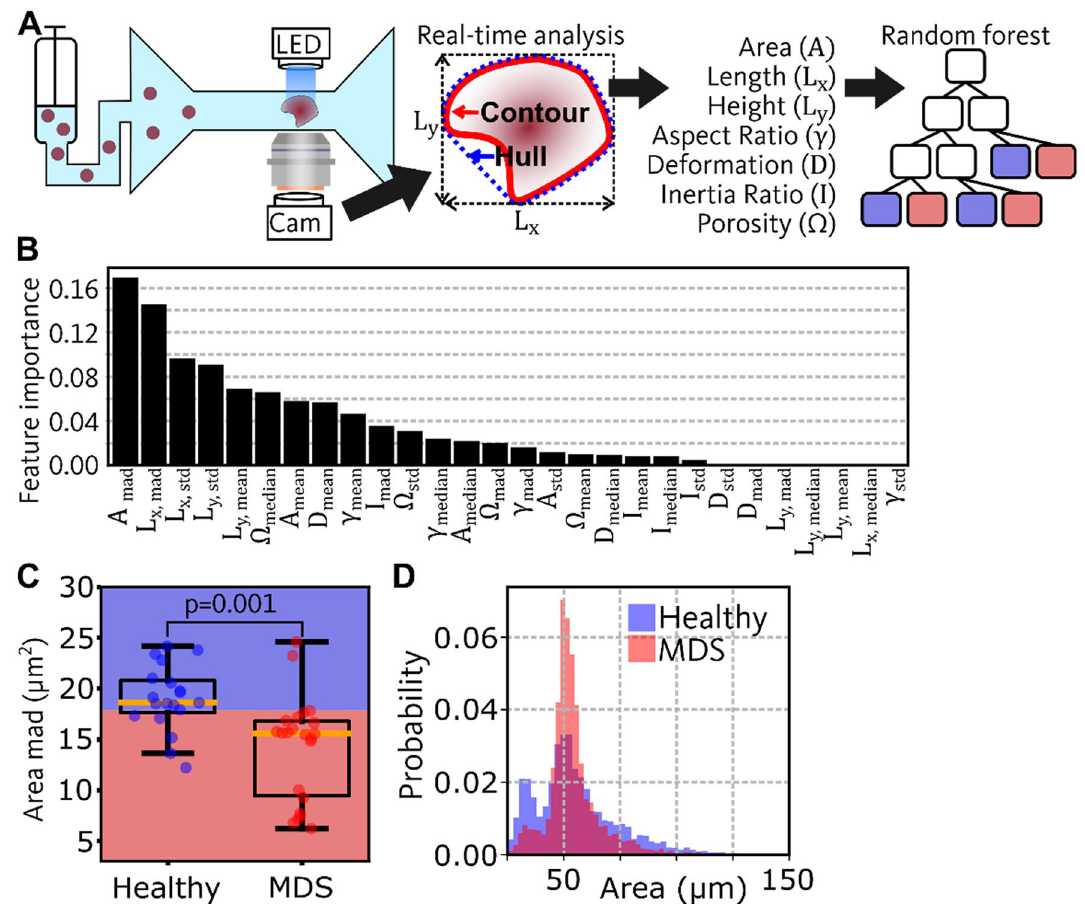
Figure 1. Detection of MDS using RT-DC and machine learning. ( A ) Sketch on the left shows the RT-DC setup. A syringe pump pushes suspended cells into a microfluidic chip which has a narrow constriction channel. Within the channel, cells are deformed and captured by a high-speed camera. Images are analyzed in real-time to obtain the contour (red), the convex hull (blue), the bounding box (dashed lines), and compute seven features. For each feature, the mean, median, standard deviation, and median absolute deviation are computed, resulting in 28 features describing the distributions. Sketch on the right illustrates a random forest model, which was trained to discriminate healthy and MDS, based on the 28 distribution features. ( B ) Barplot shows the feature importance values of a random forest model that was trained using 28 distribution features to discriminate healthy and MDS. ( C ) Boxplot shows the median absolute deviation ( mad ) of area for healthy and MDS samples. A random forest model was trained on that single feature to distinguish healthy and MDS and the resulting decision boundary is shown in the boxplot (blue corresponds to healthy and red to MDS). Boxes show the interquartile ranges ( IQR ), which are defined by the 25th percentile ( Q 1 ) and the 75th percentile ( Q 3 ): IQR = Q 3 − Q 1 . Yellow lines in the boxes show the medians. Whiskers represent the range of the data (lower bound: Q 1 − 1.5 · IQR , upper bound: Q 3 + 1.5 · IQR ). ( D ) Histograms show the distribution of area for representative measurements of healthy (blue) and MDS